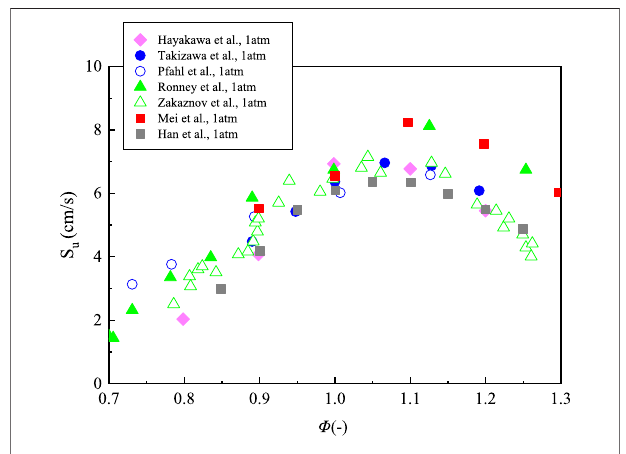
FIGURE 3 | Laminar burning velocity of NH 3 fl ame with a function of equivalence ratio at 298 K and 1 atm, replotted from (Han et al., 2019; Kobayashi et al., 2019; Mei et al.,